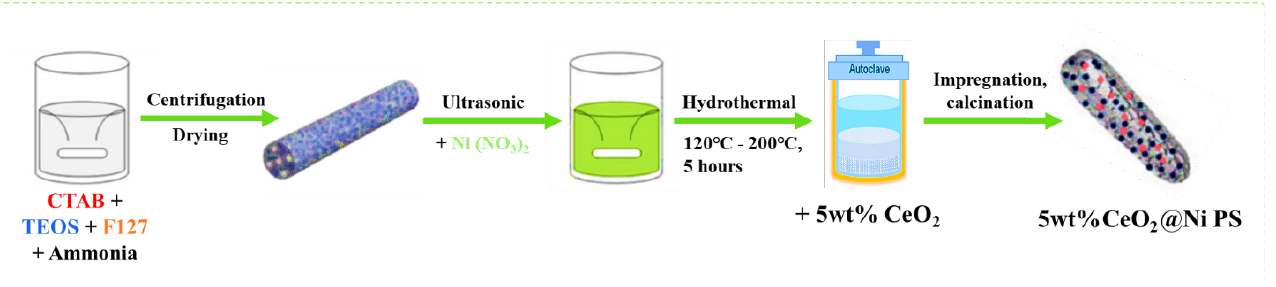
Figure 6. Schematic of formation of Ni-phyllosilicate catalysts via a hydrothermal method. Repro- duced with permission from Yang, Zhang, and Liu [81], Highly Efficient Ni-Phyllosilicate Catalyst with Surface and Interface Confinement for CO 2 and CO Methanation; copyright from American Chemical Society, 2021.